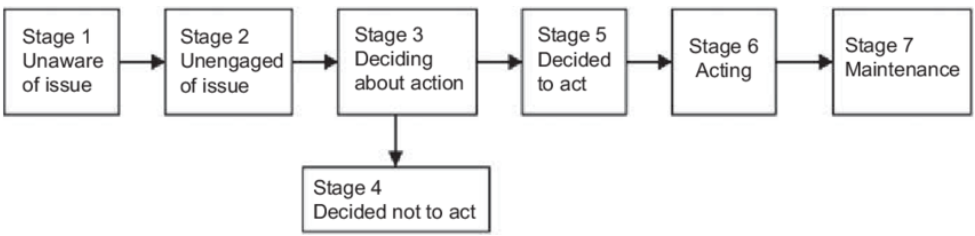
Figure 2. Stages of the Precaution Adoption Process Model.